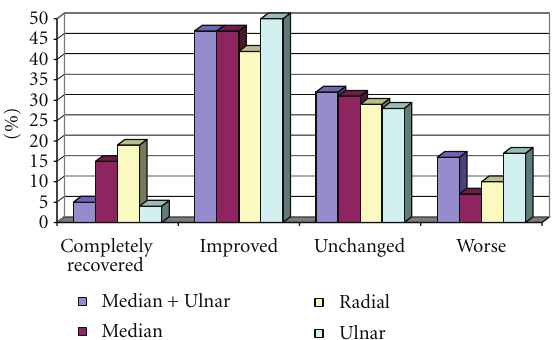
Figure 1: Patient self-reported outcome.